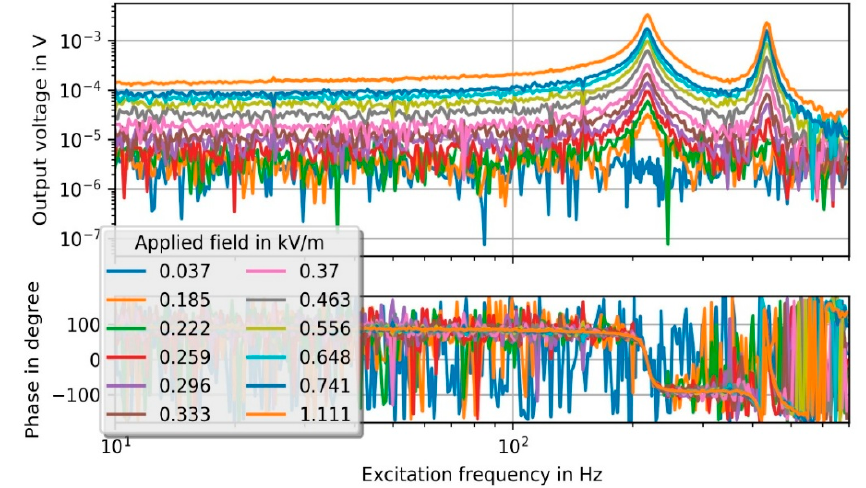
Figure 3. Measurement results for exciting the sensor with different field-strengths, also revealing the first two mechanical resonances. The resolution limit was gained from magnitude and phase information and is equivalent to 222 V/m (compare Figure 4).